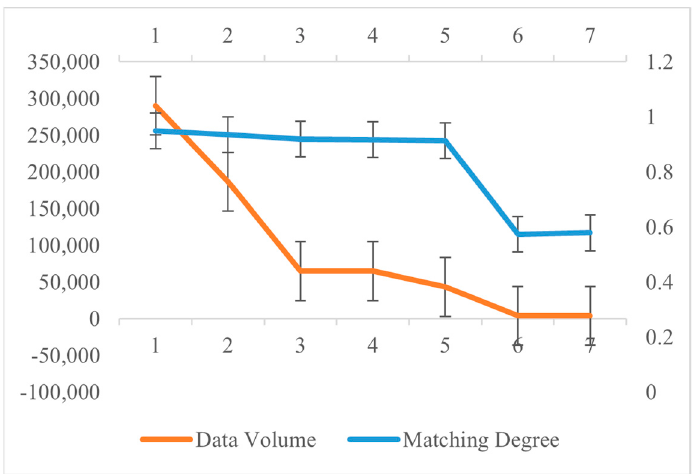
Figure 10. Changes of Hausdorff value at each layer of the neural